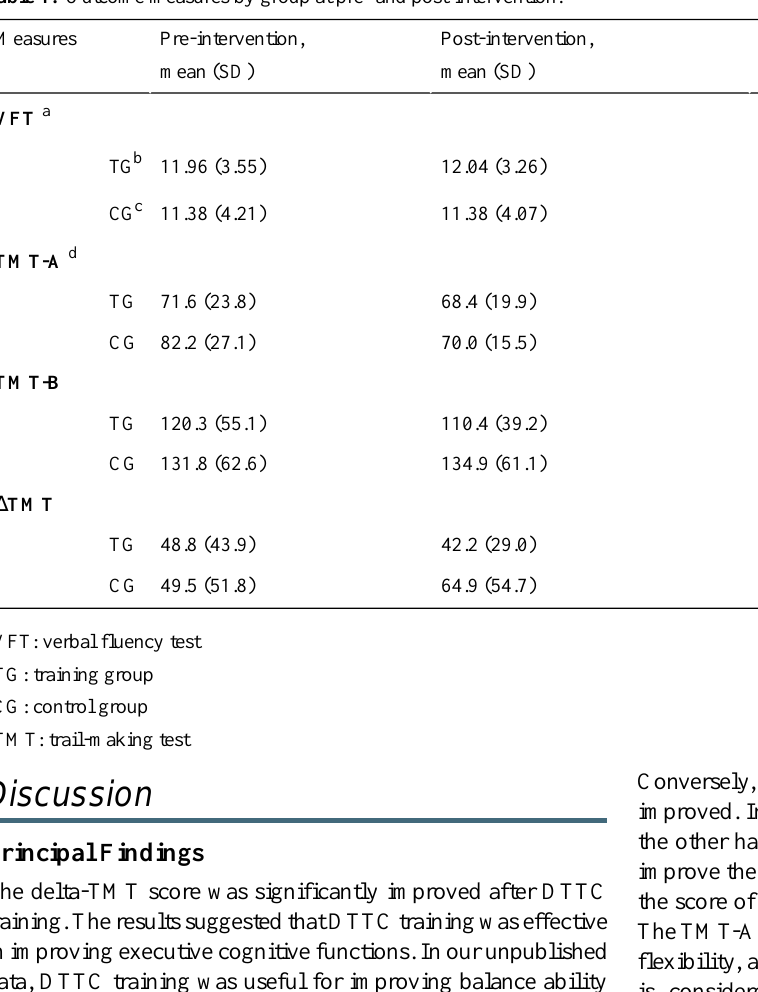
Table 1. Outcome measures by group at pre- and post-intervention.